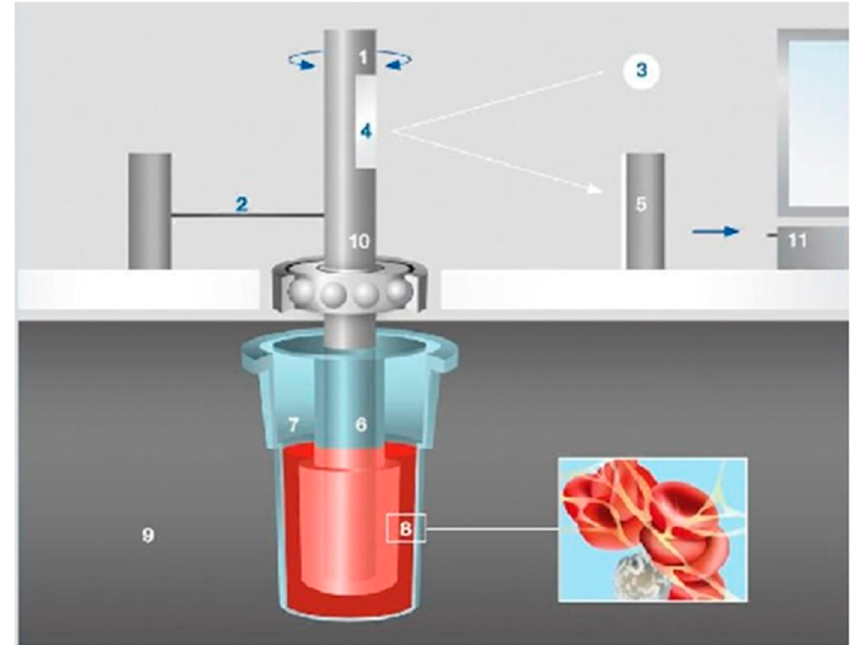
Figure 1. The principle of ROTEM analysis [10]. Legend: 1—oscillating axis, 2—counterforce Scheme, 3—light beam from LED, 4—mirror, 5—detector (electronic camera), 6—sensor pin, 7—cuvette filled with blood sample, 8—fibrin strands and platelet aggregates, 9—heated cuvette holder, 10—ball bearing, 11—data processing unit (adapted from [10]).